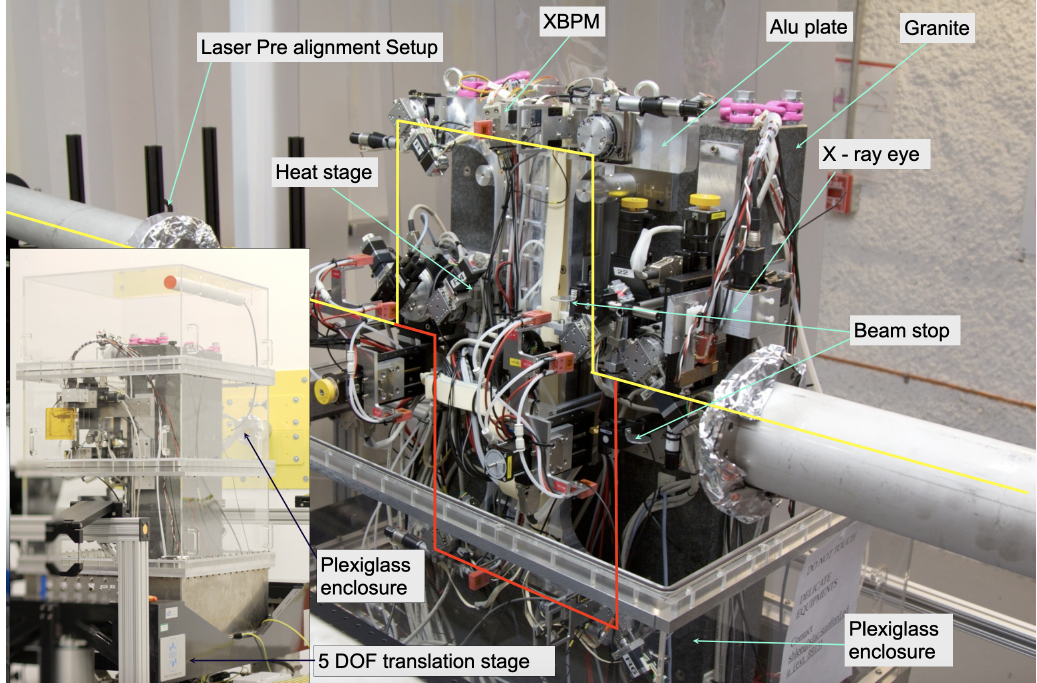
Figure 12. Top: Photograph of the first split-and-delay line [174] installed at the XCS instrument of LCLS. The incident FEL beam comes from left and is denoted by the yellow line. The beam is split at the beam splitter position into two parts that propagate inside the delay line defined by Bragg crystals of the upper branch (yellow line) and lower branch (red line). Fine adjustment of the overlap between the split beam is done by the heat stage mounted in the lower branch. Each branch is equipped with the beam stop allowing to switch promptly between the beams. To reduce the X-ray absorption in air the setup can operate in He environment thanks to the plexiglass enclosure. The inset shows the closed box that is flushed with helium to reduce parasitic